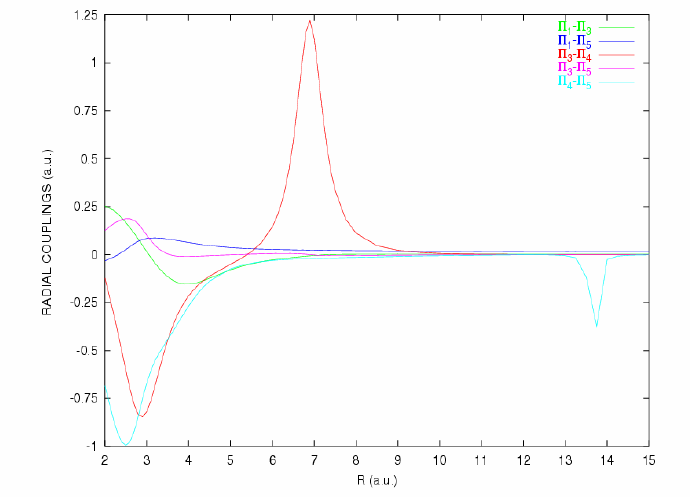
Figure 3 : Radial coupling matrix elements between 1 Π states of the S 3+ (3s 2 3p) + H collisional system (see labels in Figures